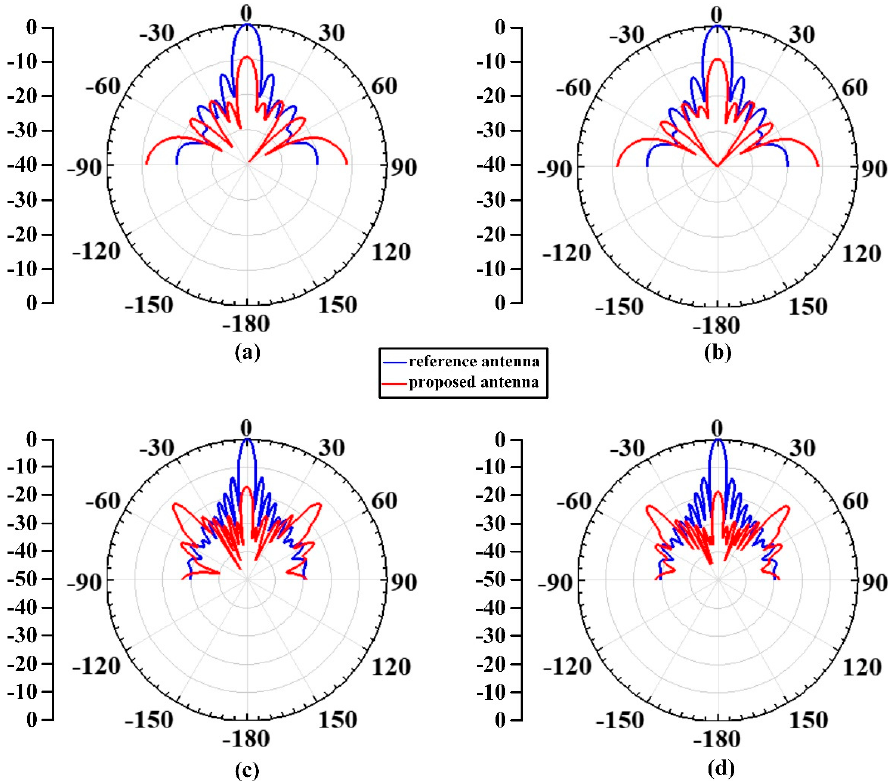
Figure 12. Normalized monostatic RCS angular response at various frequencies. ( a ) y–z plane, VP incident wave at 7.6 GHz. ( b ) x–z plane, HP incident wave at 7.6 GHz. ( c ) y–z plane, VP incident wave at 14 GHz. ( d ) x–z plane, HP incident wave at 14 GHz.